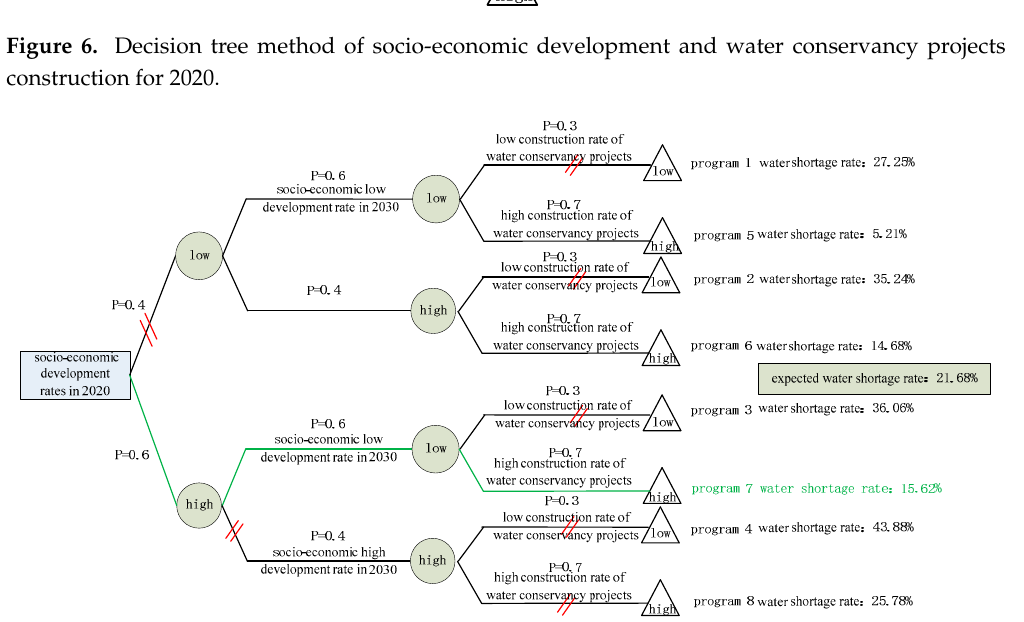
Figure 7. Decision tree method of socio-economic development and water conservancy projects construction for 2030.